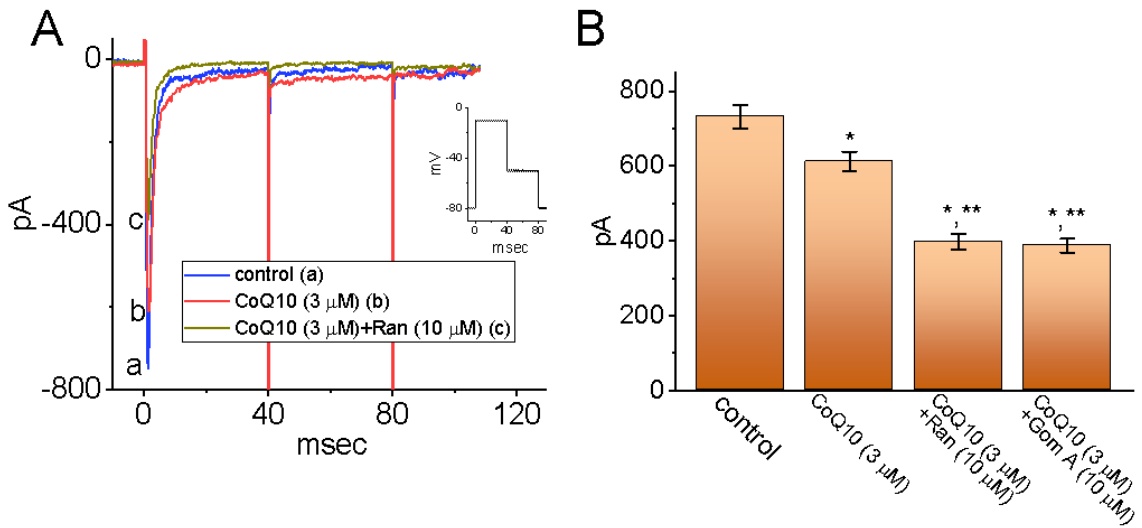
Figure 6. Effects of ubiquinone (CoQ10) on the I Na in MMQ pituitary cells. The whole-cell experiments were conducted with MMQ cells, which were kept in Ca 2+ -free Tyrode’s solution, and we backfilled the pipette with a Cs + -containing solution. ( A ) Representative current traces obtained (a) during the control period and during cell exposure (b) to 3 µ M of CoQ10 and (c) to 3 µ M of CoQ10 plus 10 µ M of ran. The inset demonstrates the voltage-clamp protocol applied to the cell. ( B ) A summary bar graph showing the effects of CoQ10, CoQ10 plus ran, and CoQ10 plus gom A (mean ± SEM; n = 8). The current amplitude was measured at the beginning of the depolarizing pulse from − 80 to − 10 mV. * Significantly different from the control group ( p < 0.05), and ** significantly different from the addition of CoQ10 (3 µ M) alone group ( p <